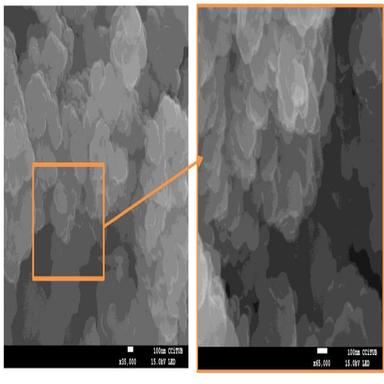
η as function of shear rate of NEPCM: a) based on CA b) based on CA–MA.